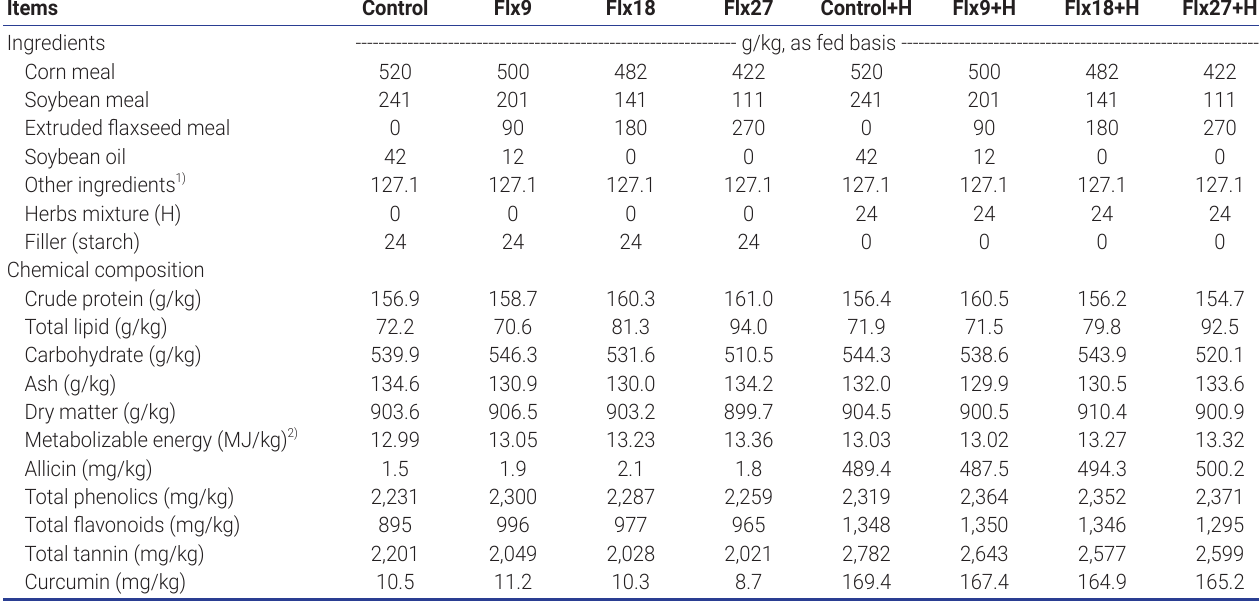
Table 1. Dietary formulation and chemical composition of diets containing graded extruded flaxseed levels and herbals